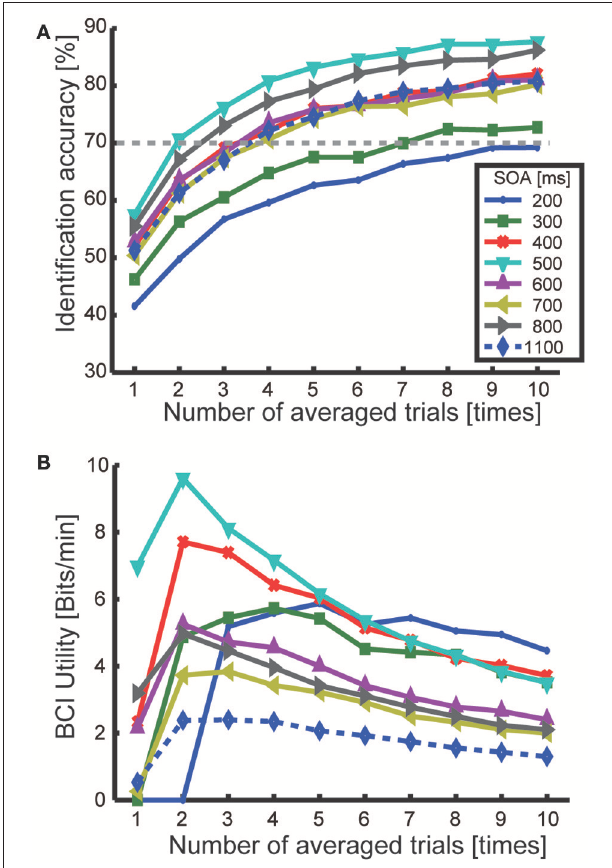
FIGURE 4 | Identification accuracy of target direction and BCI utility. (A) Identification accuracies. Each line represents the average accuracy across participants in each SOA condition as a function of the number of averaged trials (1–10 times). (B) BCI utility for each SOA condition as a function of the number of averaged